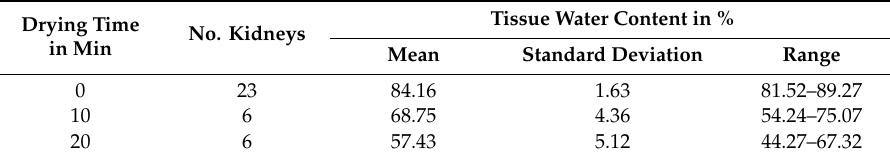
Table 1. Drying characteristics of kidney tissue using the oven drying